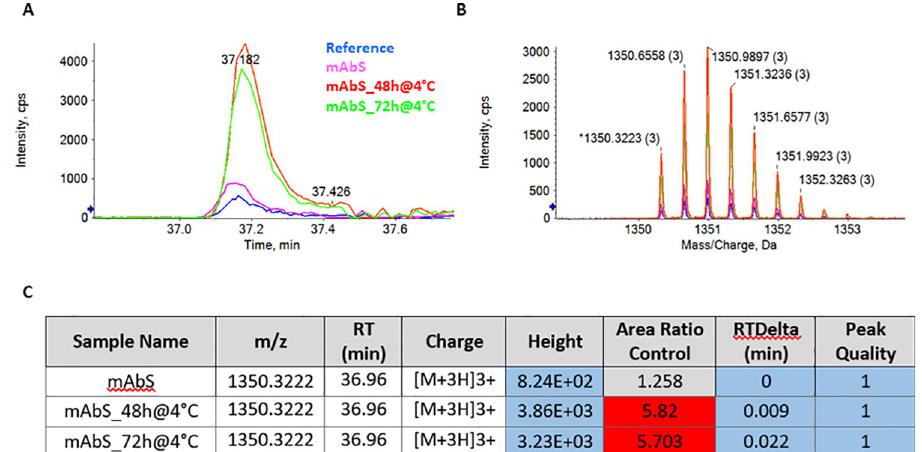
Fig 4. Implementation of New Peak Detection (NPD) workflow using the oxidation stability data (4˚C). XICs data A) and mass spectra B) of m/z ion corresponding to Moxidation 5 of the reference, mAb S, mAb S_48h@4˚C and mAb S_72h@4˚C samples. C) MS data information showing the flagged peaks according to the defined criteria. Samples with a changed Moxidation_5 peak are highlighted in red (Fold changes � 3). The NPD criteria highlighted in blue, indicate peaks that pass the criteria (peak height > 500 counts, peak quality > 0.6, retention time delta � 0.2 min). No flagged peak was detected for sample mAb